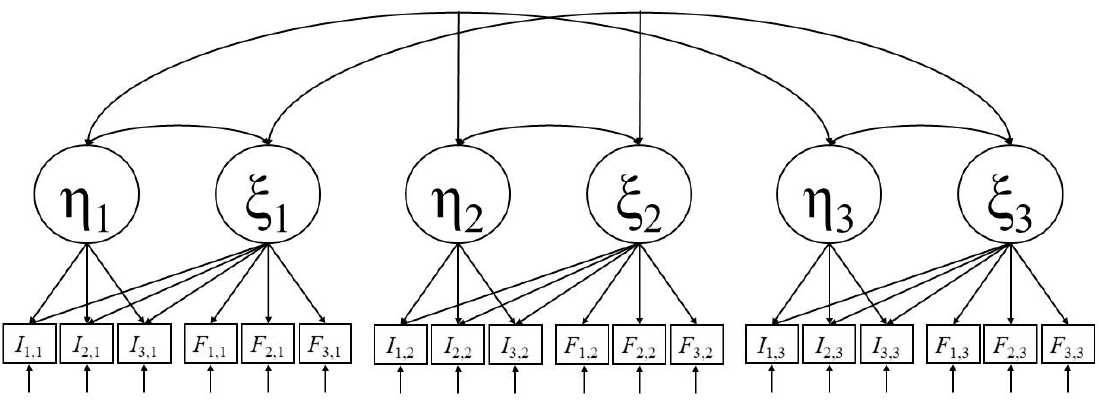
Figure 2. Extension of the AT model [36] to longitudinal data (LAT model). An AT model (Figure 1) is constructed for every test session i (three in this example but it can be extended to any number of test sessions). States of latent cognitive ability ( η i ) are modeled to correlate between test sessions. The same is applied to latent state anxiety ( ξ i ).